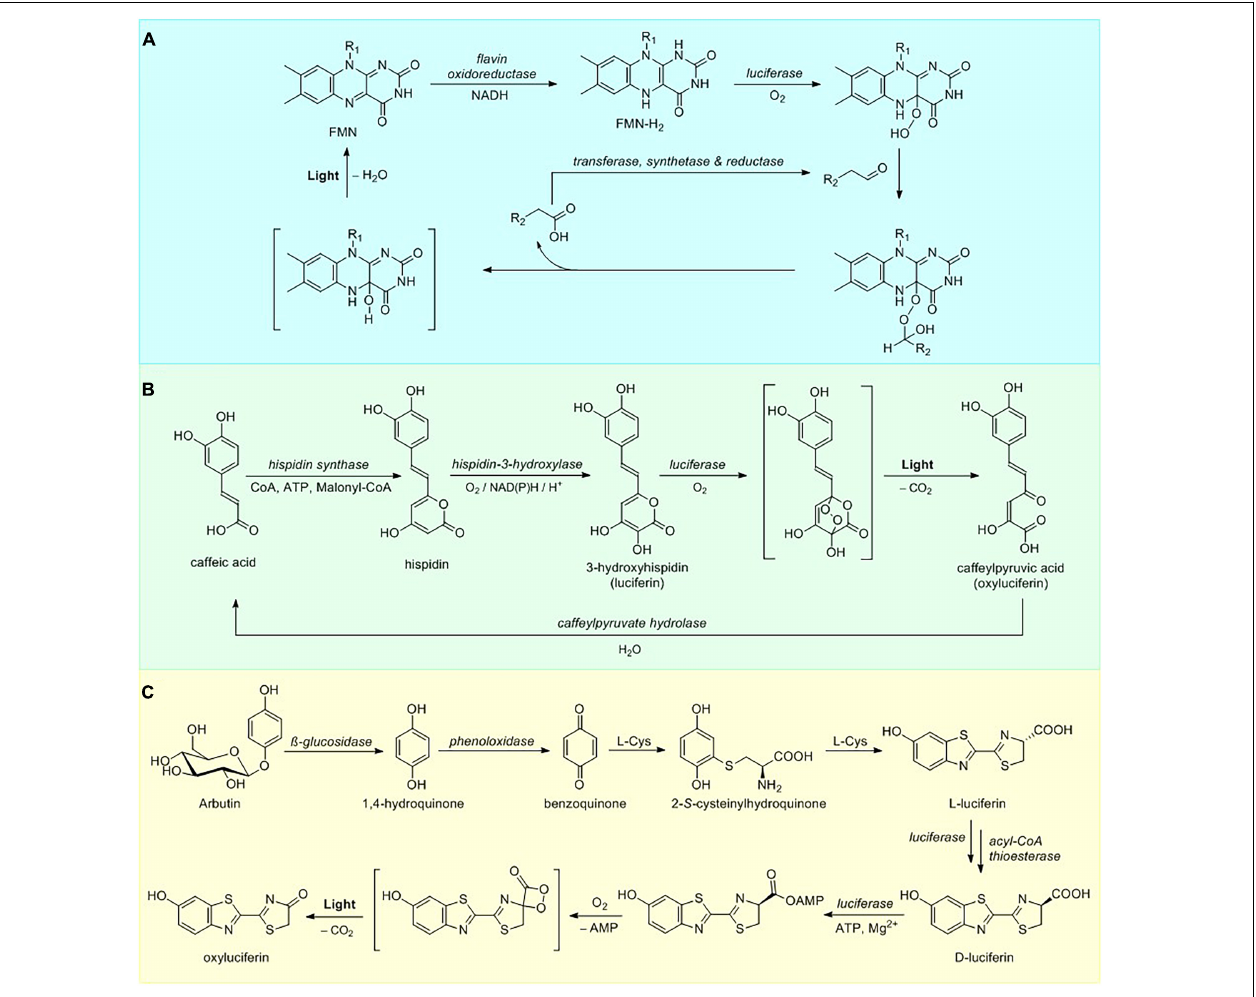
FIGURE 2 | Luciferin metabolism. (A) Overview of bacterial luciferin bioluminescence and recycling pathways. (B) Pathway of fungal luciferin biosynthesis and recycling. (C) Partial D-luciferin biosynthetic pathway and bioluminescence